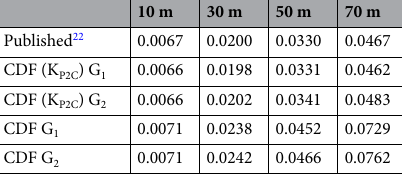
Table 1. Comparison of the ratio of the lightning rod and ground